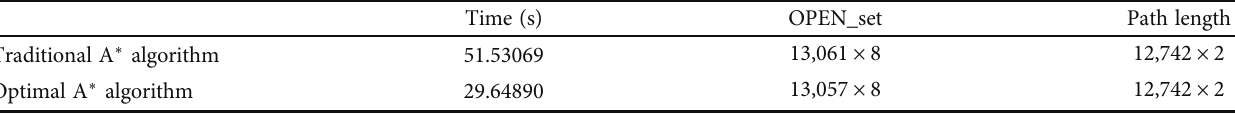
Figure 7: UAV swarm path planning via the optimal A ∗ algorithm in the 3D environment. Table 3: Comparison between time cost and memory space of the optimal A ∗ algorithm and the traditional A ∗ algorithm.